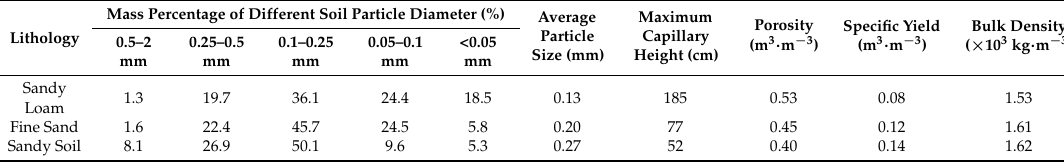
Figure 2. Schematic diagram of a field lysimeter. Table 2. Properties of the soils in the lysimeters.